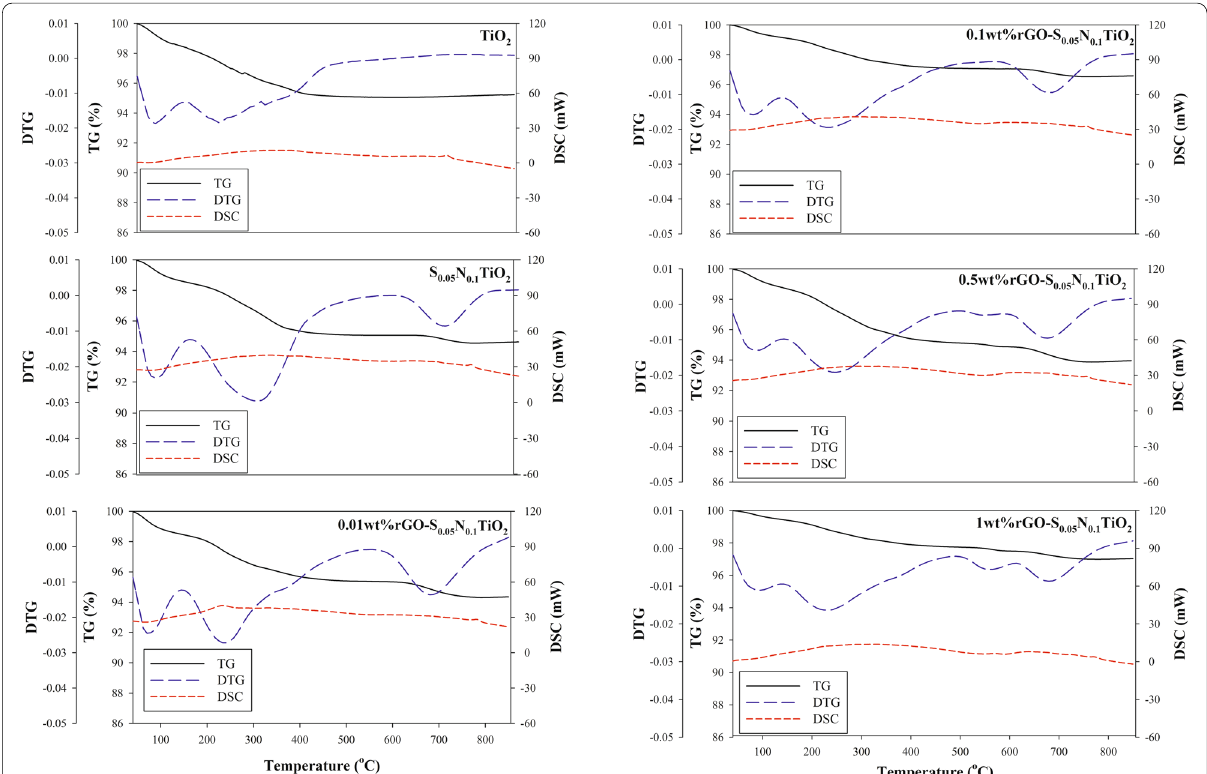
Fig. 4 TG‑DTA curves of bare TiO 2 and various synthesized photocatalyst